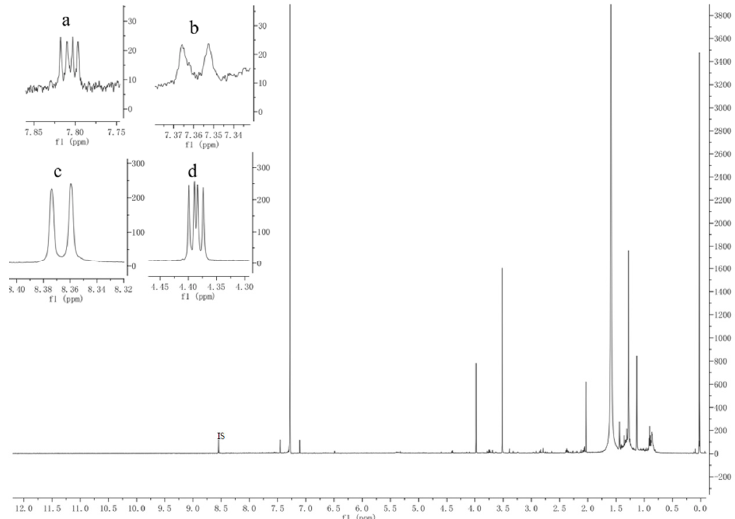
Figure 3. Representative 1H-NMR spectra for Tan I ( a ), Tan IIA ( b ), DTS ( c ) and CTS ( d ) with IS in the full range of 0 to 12.0 ppm. (Material is PS02, a, b, c, and d respectively represent the local magnifications of the four signal peaks).